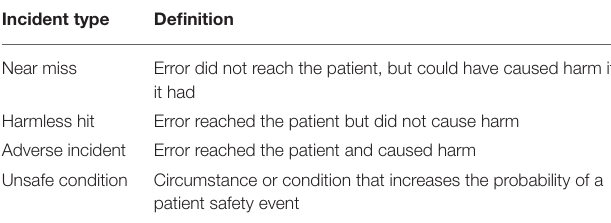
TABLE 2 | Incident types and their